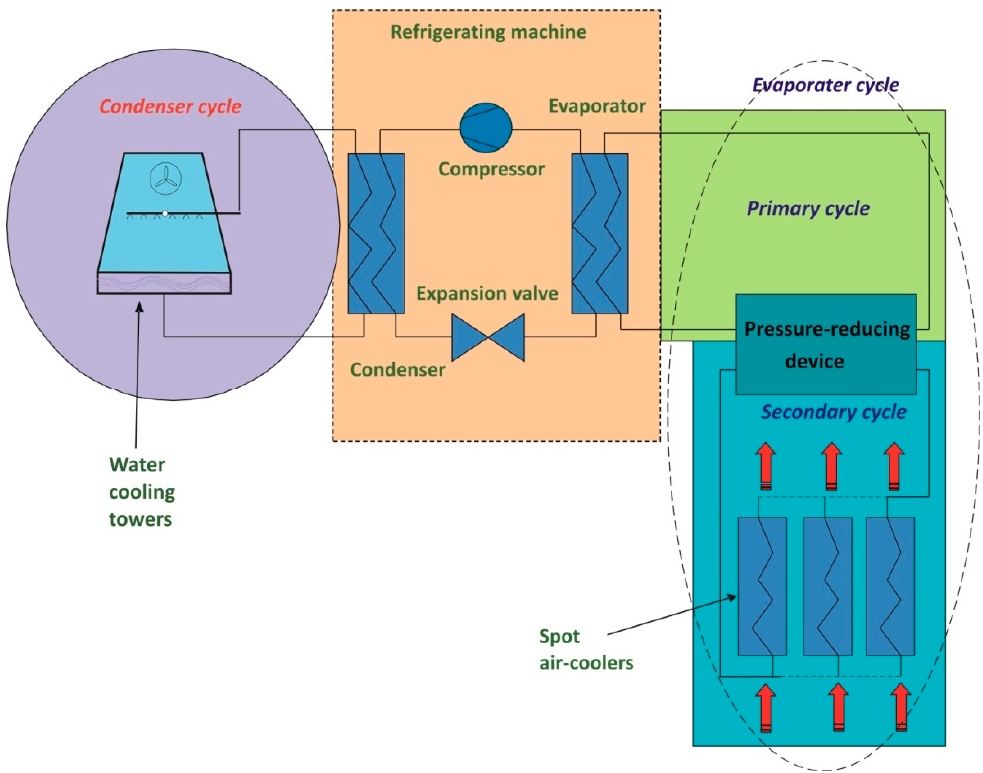
Figure 2. Schematic diagram of “a central” cooling system with a surface refrigeration plant.